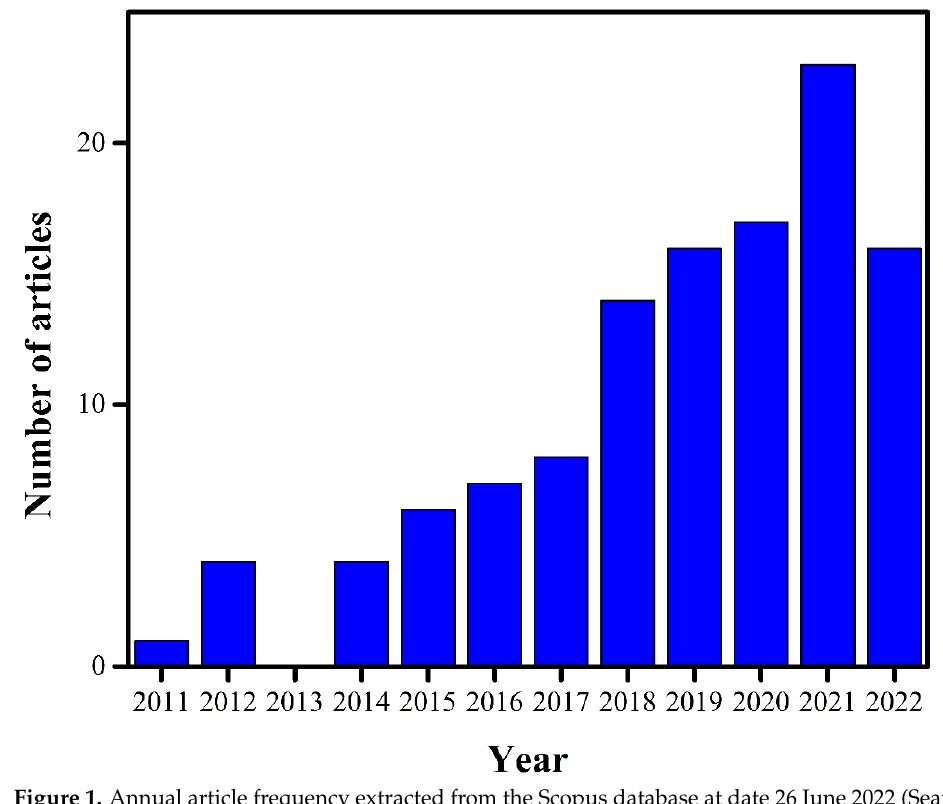
Figure 1. Annual article frequency extracted from the Scopus database at date 26 June 2022 (Searched with the keyword ‘effects of tap water on pollutants degradation’).